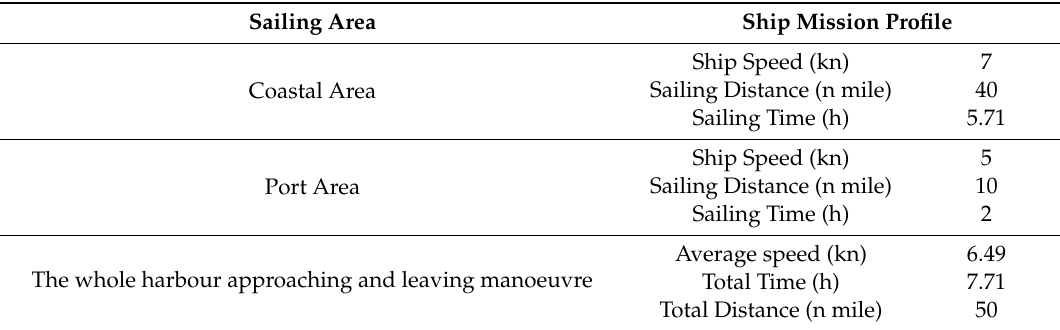
Table 6. Ship mission profile sailing in coastal and port areas.